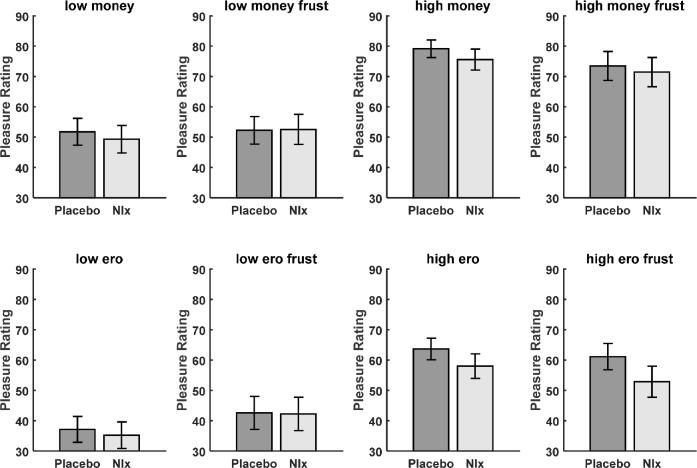
Behavioral rating data.Top row: Pleasure and frustration ratings for received and missed monetary rewards. Bottom row: Pleasure and frustration ratings for received and missed erotic picture rewards.